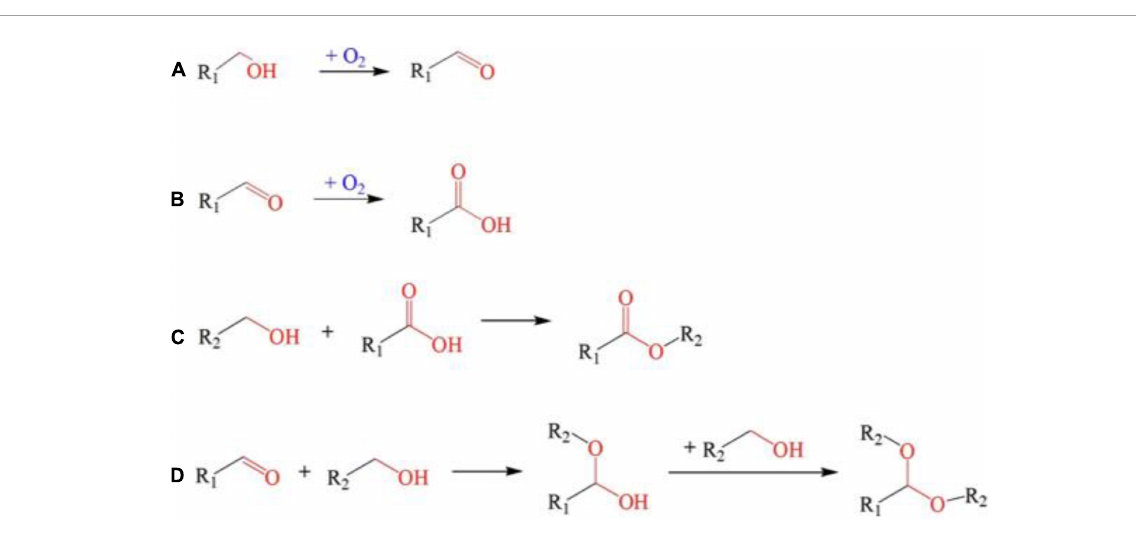
to that of bottle storage for 90 days. The phenomenon revealed that the application of external PEF affected the molecular structure and chemical reactions among the substances in wine (81). Similarly, the fatty acids such as isovaleric acid, hexanoic acid, and octanoic acid in Chinese rice wine treated with PEF (2 kV/cm, 0.5 Hz, 36 pulses) could reach the level of natural aging for 3 years